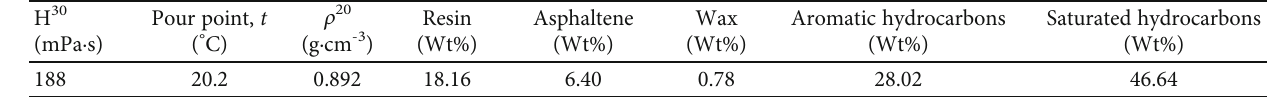
Table 1: The major physical properties of Yanchang Oil fi eld Chang 6 crude